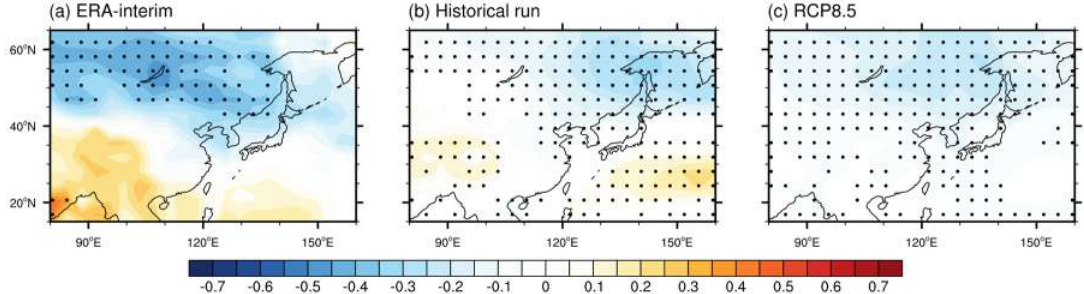
Figure 6. The interannual correlation coefficient between the occurrence of cold surges and the boreal winter SAT for ( a ) 1979–2016 in ERA-Interim (values significant at the 95% confidence level are represented by black dots), ( b ) 1975–2005 in the historical run, and ( c ) 2065–2095 in ensemble mean of nine CGCMs based on RCP8.5 scenario. Regions with same sign in at least 6 CGCMs are represented by black dots.